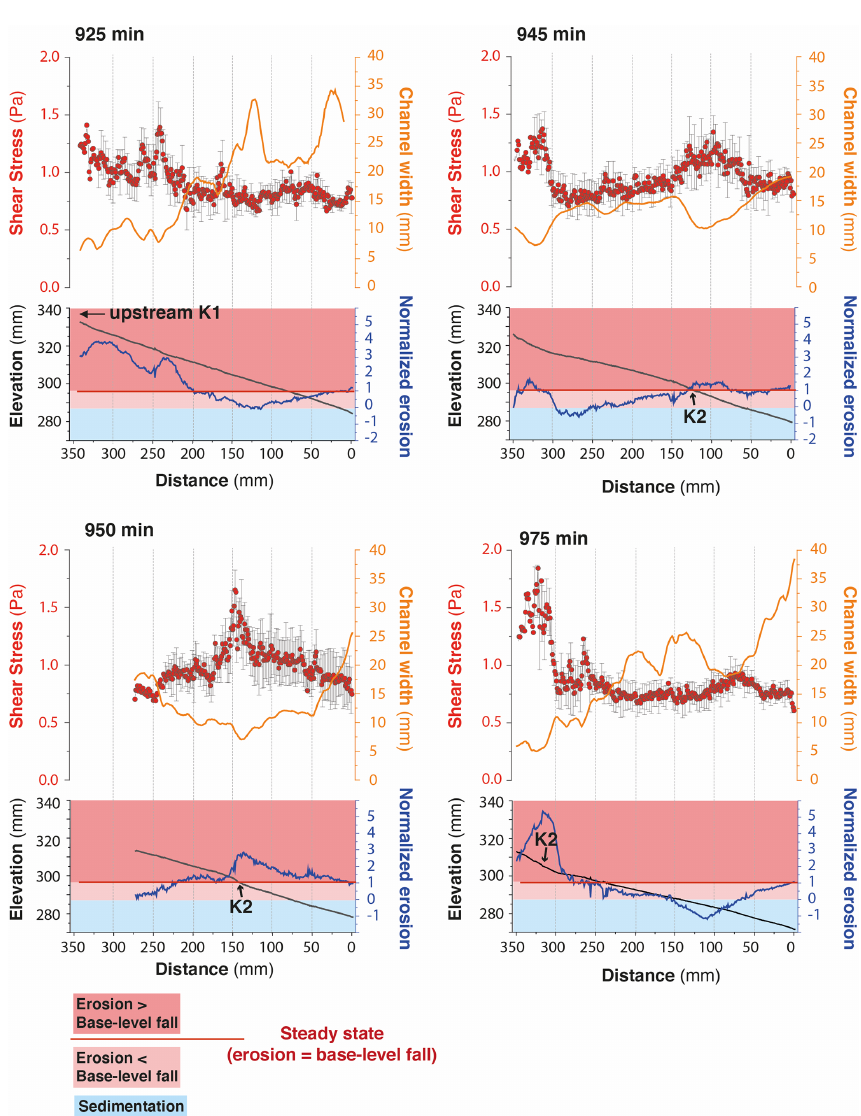
Figure 12. Longitudinal trends of hydro-geomorphic parameters in experiment BL15 at run times 925, 945, 950 and 975min (see text for comments). K1 and K2: first and second knickpoints discussed in the text (see also Fig.